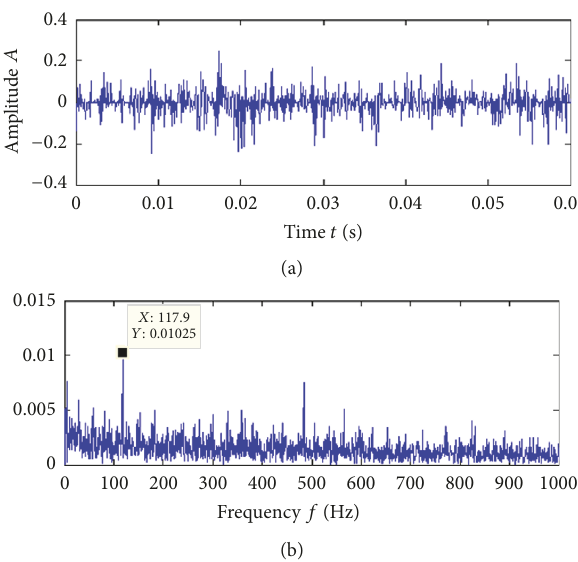
Figure 14: Extraction result of slight rolling element fault: (a) time waveform and (b) envelope